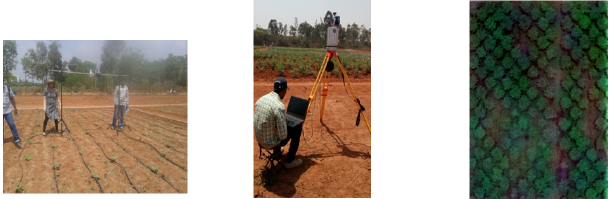
Figure 1: Data collections using Terrestrial Hyperspectral Imager and Drone mounted with hyperspectral